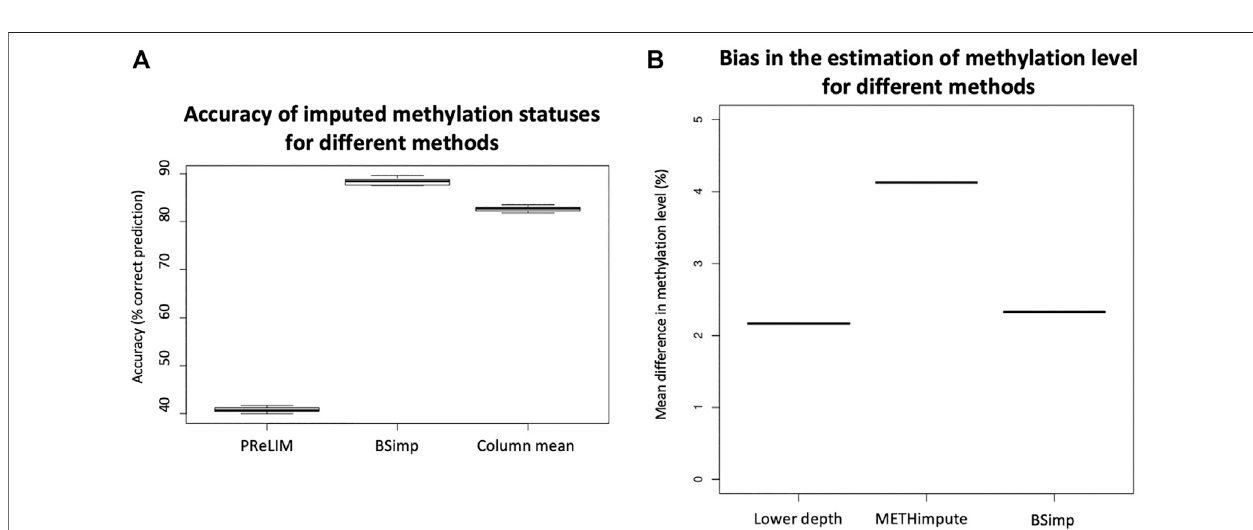
FIGURE3| EvaluationofaccuracyofBSimpbycomparingwithexistingmethods. (A) BoxplotofaccuracyofmethylationstatusesimputedcomparedwithPReLIM and column mean. Non-overlapping windows of four CGs are extracted, multiple methylation statuses removed at random and imputed using all three methods to calculate mean accuracy of prediction for each window. PReLIM needs training of models, (complete parts of) all windows included in the evaluation were used for training. Column mean is a method that uses methylation level for the genomic position as the probability of methylation for all reads eligible for imputation. The results are based on 783 windows. (B) Boxplot of mean difference in methylation level of common regions compared with METHimpute and data of lower depths. Four libraries were obtained by downsampling 50% of reads independently and imputed using METHimpute and BSImp. Methylation levels obtained before and